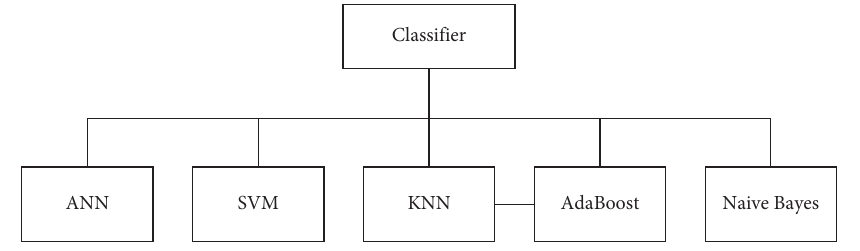
Figure 2: Different supervised classifiers.